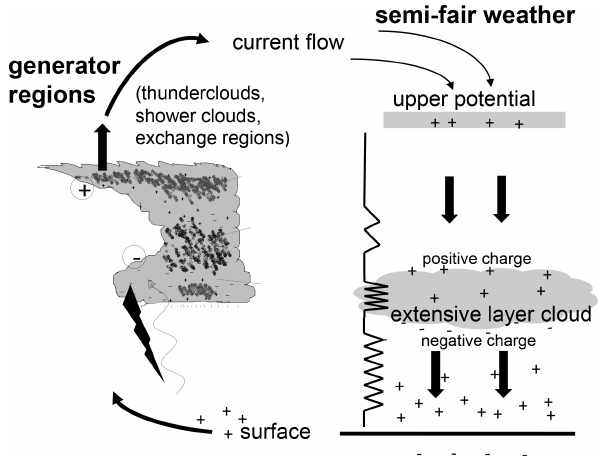
Figure 4. Conceptual picture of the global atmospheric electric cir- cuit in which a current is generated in disturbed weather regions and returns through distant fair weather and semi-fair weather re- gions. As the current returns through extensive layer clouds, charge accumulates at their upper and lower boundaries.